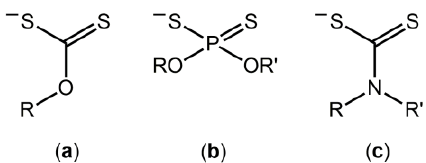
Figure 1. Chemical diagrams for 1,1-dithiolate ligands covered in this survey: ( a ) xanthate (O- Figure alkyldithiocarbonate); ( b ) dithiophosphate; and ( c ) dithiocarbamate. R, R’ = alkyl, aryl.